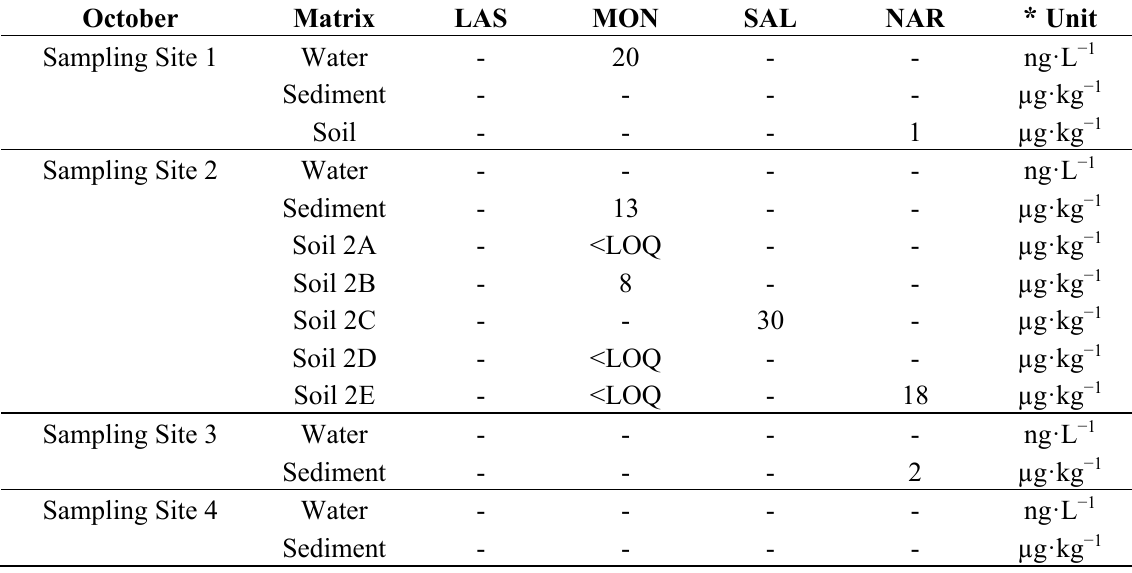
Table 2. Results of October 2012 sampling campaign at Sites